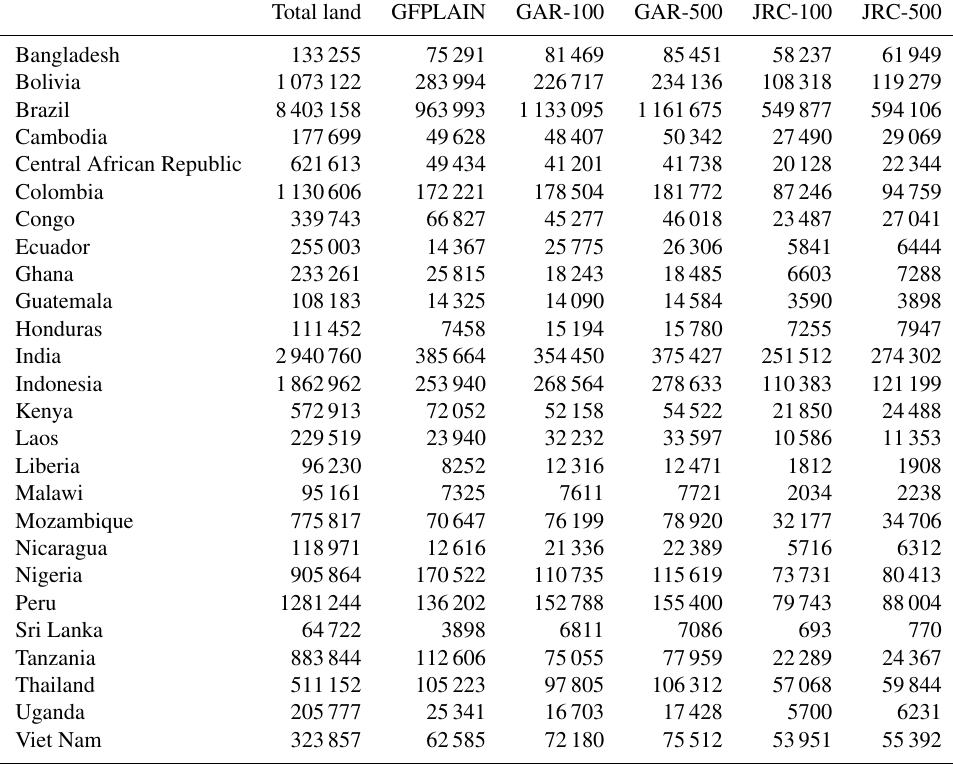
Table A8. Total land area and flood-prone area (square kilometres) using GFPLAIN, JRC-100, JRC-500, GAR-100, and GAR-500. Land area is the total country area minus surface water area, given by the water mask MOD44W. The percentage of country area that is normally occurring surface water is less than 5% for all countries, except Uganda with Lake Victoria (15%) and Malawi with Lake Malawi